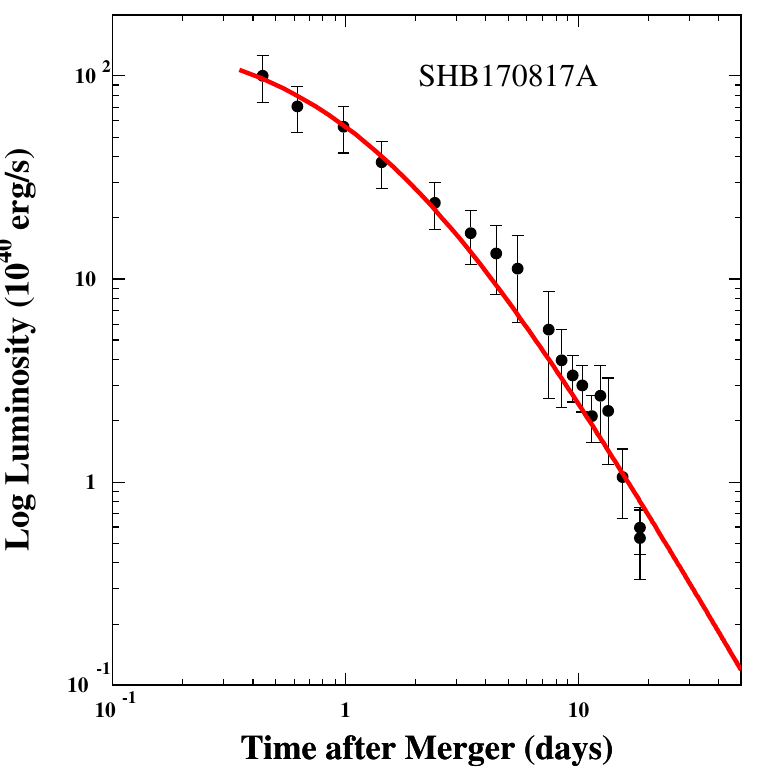
Figure 34. Comparison between the observed [118] bolometric light curve of SHB170817A and the universal light curve of Equation (19), assuming the presence of a milli-second pulsar with L ( 0 )= 2.27 × 10 42 erg/s and t b = 1.15 d. The fit has χ 2 /dof =